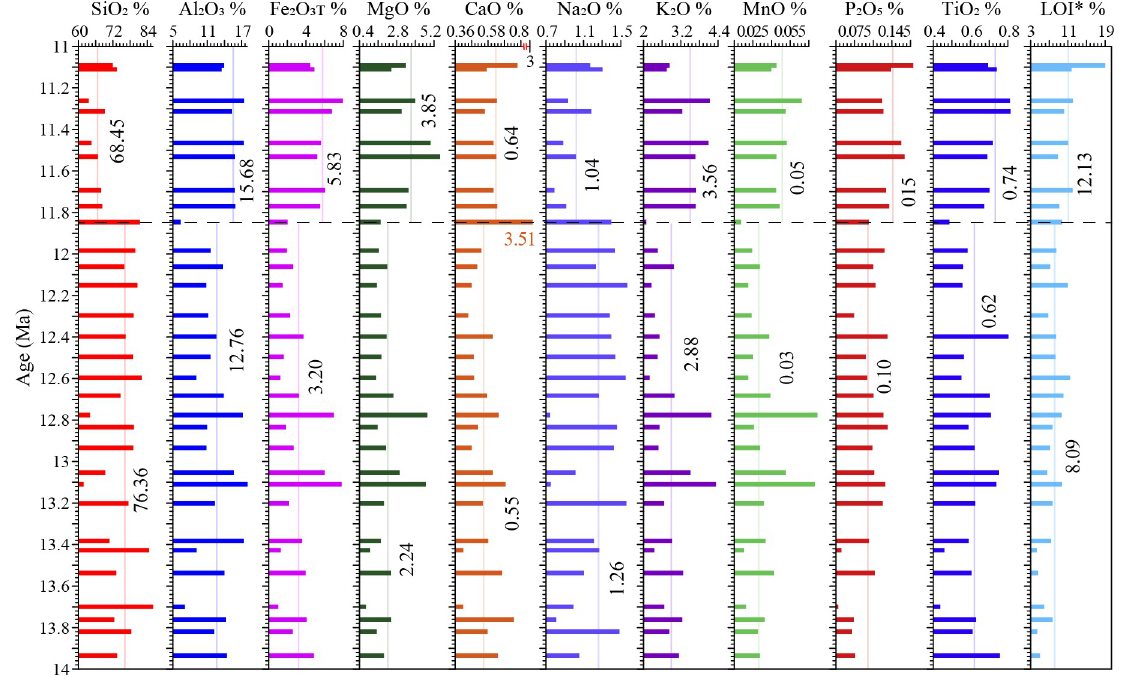
Fig 2. Major element abundances of the fluviolacustrine samples from the Sikouzi section. All major element abundances were recalculated on a volatile-free basis.